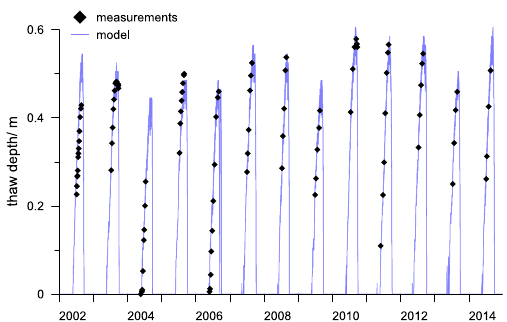
Figure 5. Modeled and measured thaw depths on Samoylov Island. The measurements correspond to the average of 150 locations on Samoylov Island (Boike et al., 2013). The average standard devia- tion of the measurements (i.e., the spatial variability of thaw depths) is 0.06m. The blue area depicts the spread between model runs with snow densities of 200 and 250kgm − 3 .